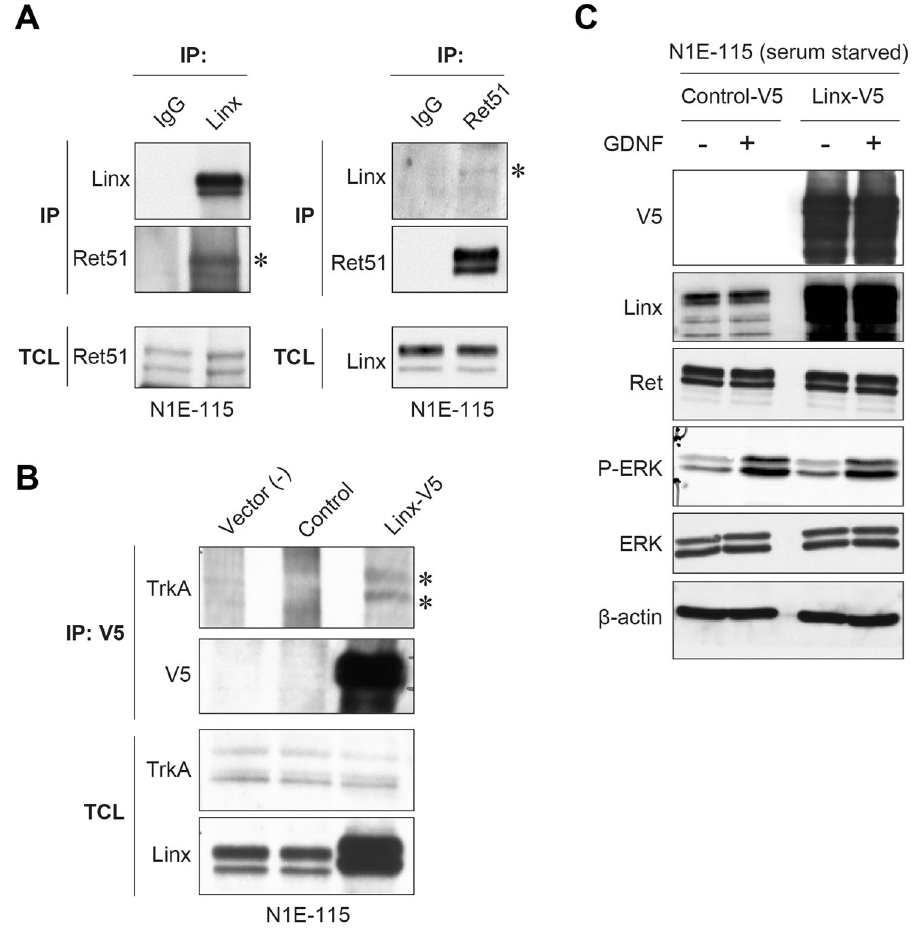
Figure 5. Interaction of Linx with RTKs and its effect on ERK signaling. (A) Linx interaction with Ret. Lysates from N1E-115 cells were immunoprecipitated (IP) using Linx (left) and Ret51 (right; an isoform of Ret) antibodies, followed by Western blot analysis with the indicated antibodies. Asterisks indicate co- immunoprecipitated Ret51 and Linx. TCL, total cell lysates. Full blot images are shown in Supplementary Figure S3. (B) Linx interaction with TrkA. Lysates from N1E-115 cells transfected with either control or Linx-V5 vector were immunoprecipitated with V5 antibody, followed by Western blot analysis. Asterisks indicate co-immunoprecipitated TrkA. Full blot images are shown in Supplementary Figure S3. (C) N1E-115 cells transfected with either control or Linx-V5 vector were starved and stimulated with GDNF, followed by Western blot analysis using the indicated antibodies. Full blot images are shown in Supplementary Figure